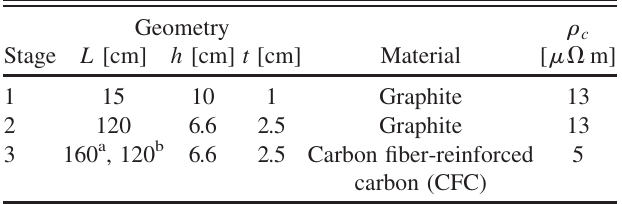
TABLE I. Geometry and material properties of the three dif- ferent measurement stages (see text).